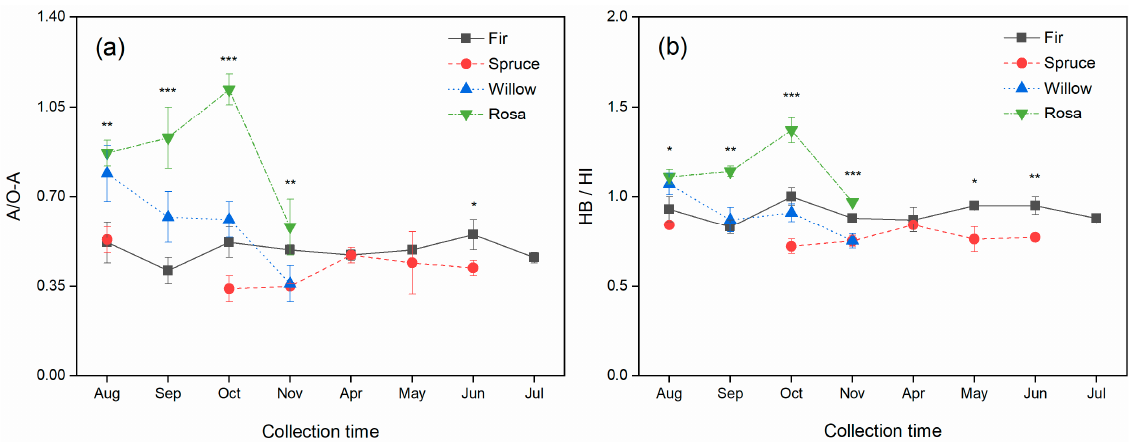
Figure 3. Monthly dynamics of the ratio of ( a ) aliphatic C to O-alkyl C (A/O-A) and ( b ) the index of hydrophobicity (HB/HI, (0–45 ppm + 110–165 ppm)/(45–110 ppm + 165–190 ppm)) in newly shed foliar litter determined via CP/MAS 13 C NMR spectroscopy. The * indicates significant ( p < 0.05) differences among the various plant species. * p < 0.05, ** p < 0.01, and *** p < 0.001.